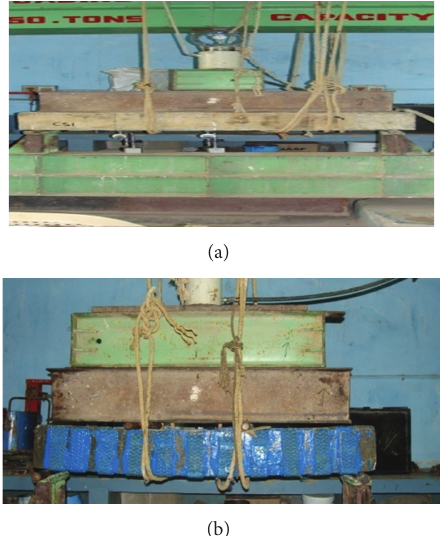
Figure 6: (a) two-point loading system on a 50ton loading frame; (b) loading on strip wrapped beam with woven sisal